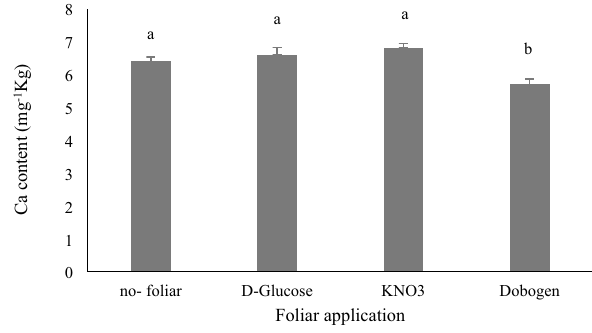
Figure 5. Mean comparisons for the effects of 2 g L −1 glucose, 2 g L −1 KNO 3 and 2% Dobogen biostimulant foliar application on the calcium content of Tanacetum balsamita plants grown hydroponically in perlite. Significant differences among treatments are indicated by different Latin letters ( P ≤ 0.01) according to Duncan’s multiple range test.